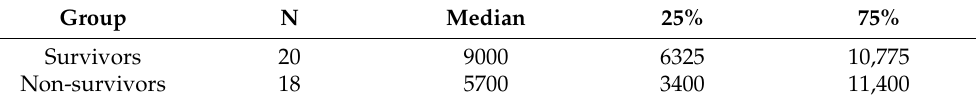
Table 5. Results of WBC counts (cell/ µ L) depending on survival. Control group was not included. Group N Median